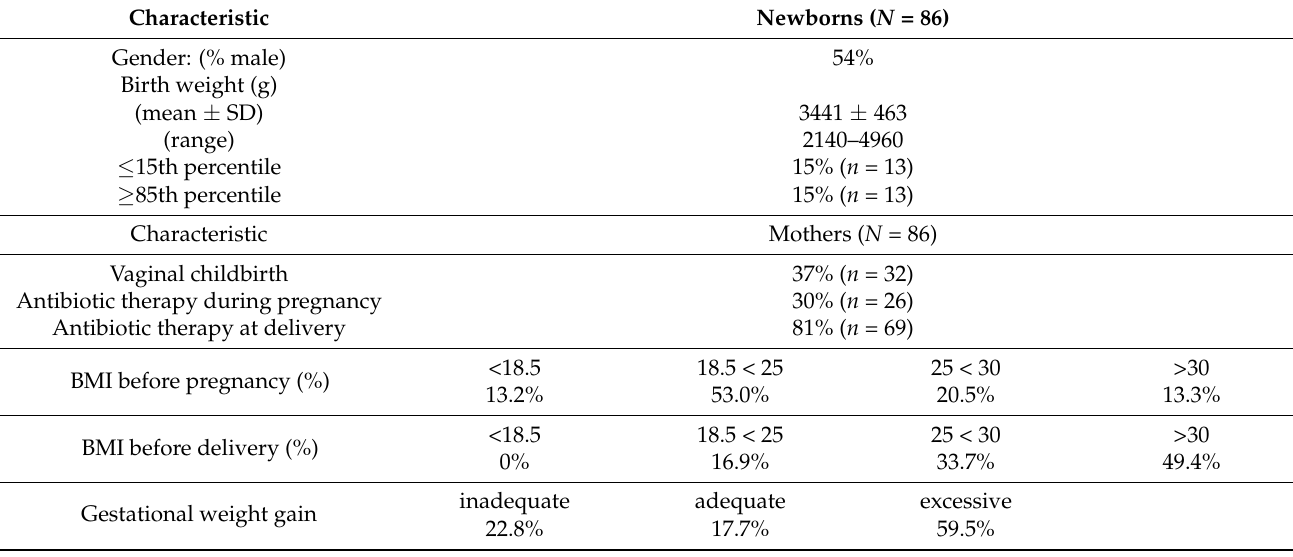
Figure 1. Study flow chart. Technical reasons—problems with collecting stools from diapers due to liquid consistency and small volume; LOD—limit of determination. Table 1. Group characteristics: newborns and